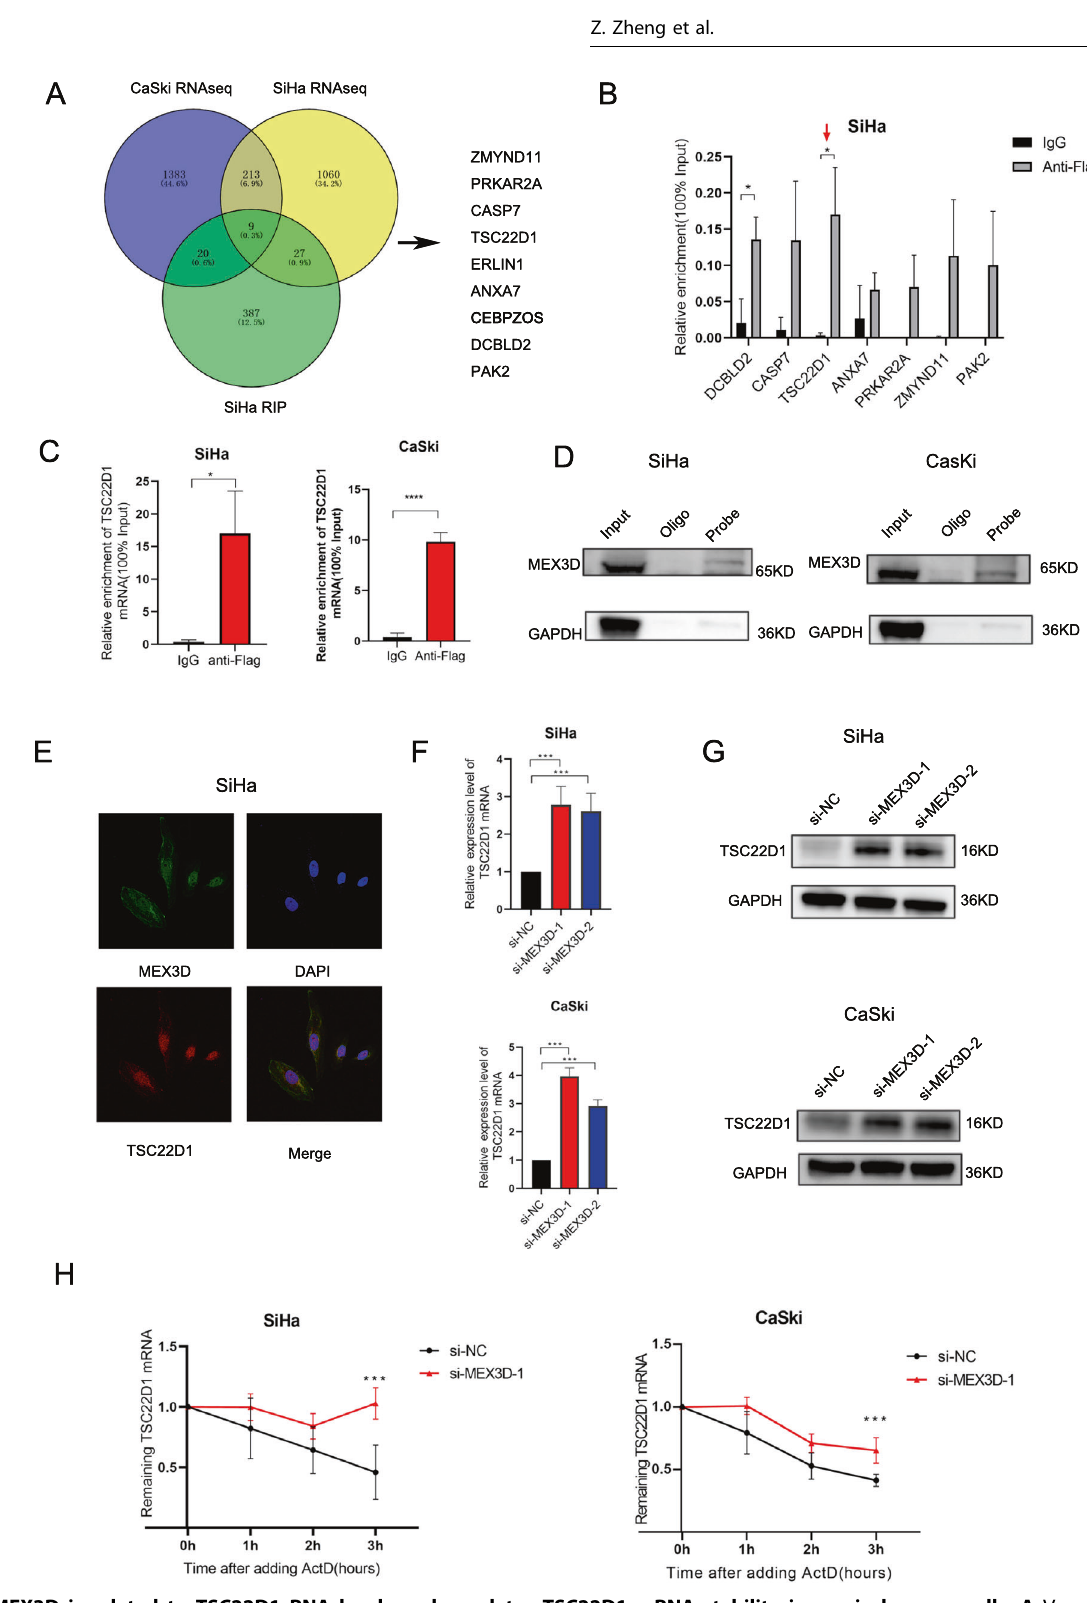
Fig. 3 MEX3D is related to TSC22D1 RNA levels and regulates TSC22D1 mRNA stability in cervical cancer cells. A Venny diagram of transcripts stabilized and bound by MEX3D. Transcripts bound by MEX3D in the RIP sequencing data and transcripts destabilized upon MEX3D knockdown in CaSki and SiHa cells. B The mRNA levels of seven genes were determined utilizing qRT-PCR in SiHA cells overexpressing MEX3D. When comparing the anti- fl ag sample to the IgG sample, TSC22D1 mRNA was substantially enriched. C TSC22D1 mRNA was found to bind to MEX3D and con fi rmed by RIP assay both in CaSki and SiHa cells. D , E For validating the interactions of MEX3D with TSC22D1, RNA pull-down and RNA- fl uorescent in situ hybridization assays were done. F , G Downregulation of MEX3D expression in CaSki and SiHa cells elevated TSC22D1 mRNA and protein levels. H To inhibit RNA synthesis, actinomycin-D was added. TSC22DQ mRNA levels in CaSki and SiHa cells with MEX3D were knockdown or not. * P < 0.05, *** P < 0.001, and **** P < 0.0001. Cell Death Discovery (2022)